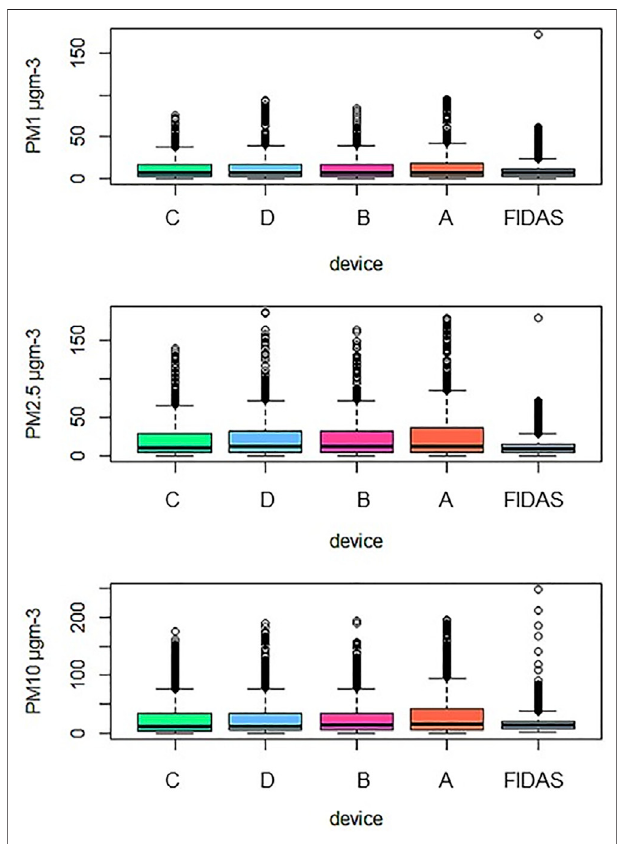
FIGURE 4 | Box plot of particulate matter concentrations from low-cost sensors and FIDAS for PM 1 , PM 2.5 , and PM 10 .